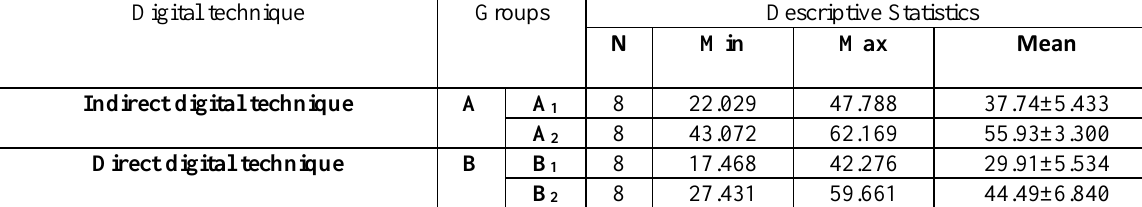
Table 1: Descriptive statistics of vertical marginal gap for all groups in (μm) . Digital